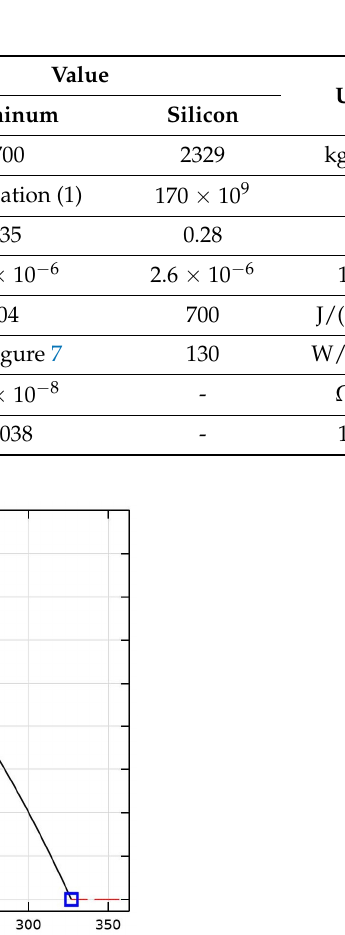
Table 2. Material properties used for FEM simulations.